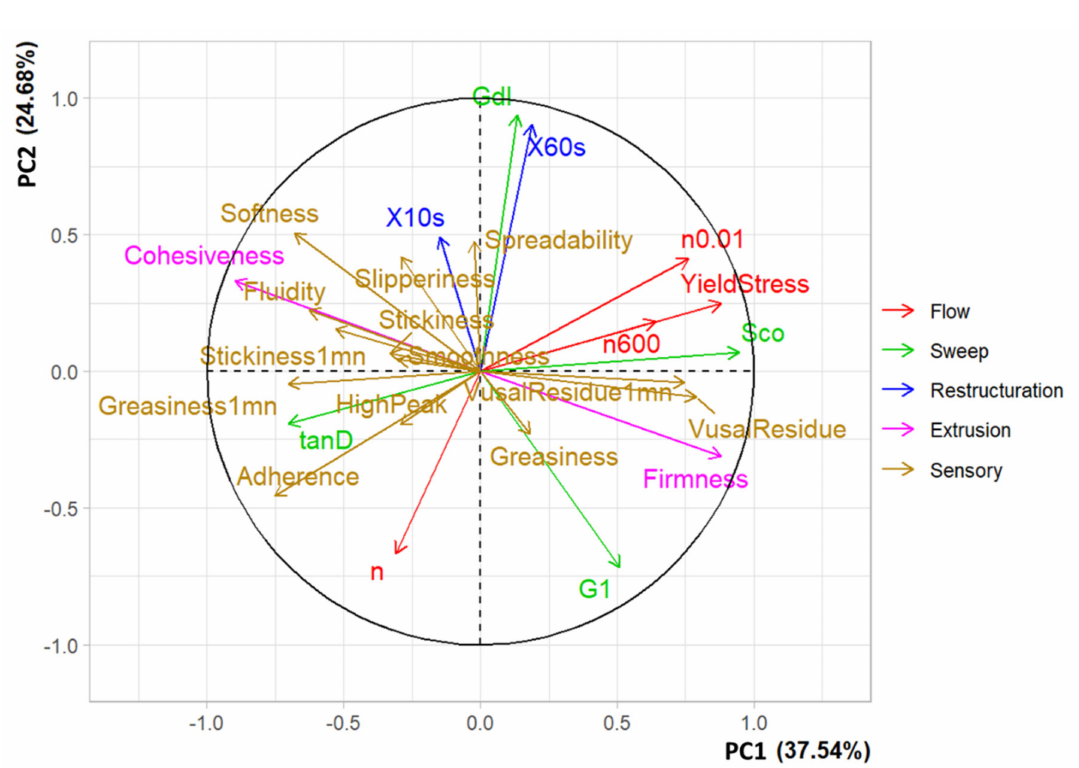
Figure 9. MFA plot of the sensorial and instrumental parameters (variables PC1/PC2 (PC1 39.33%. PC2 23.88%). Because of R software, some variables are different in the figure than in the text. n0.01 = η (0.01). X60 s = 60 s (%). X10S = 10 s (%). G1 = G (cid:48) . tan D = tan δ . Sco = σ crossover . Gdl = γ DL